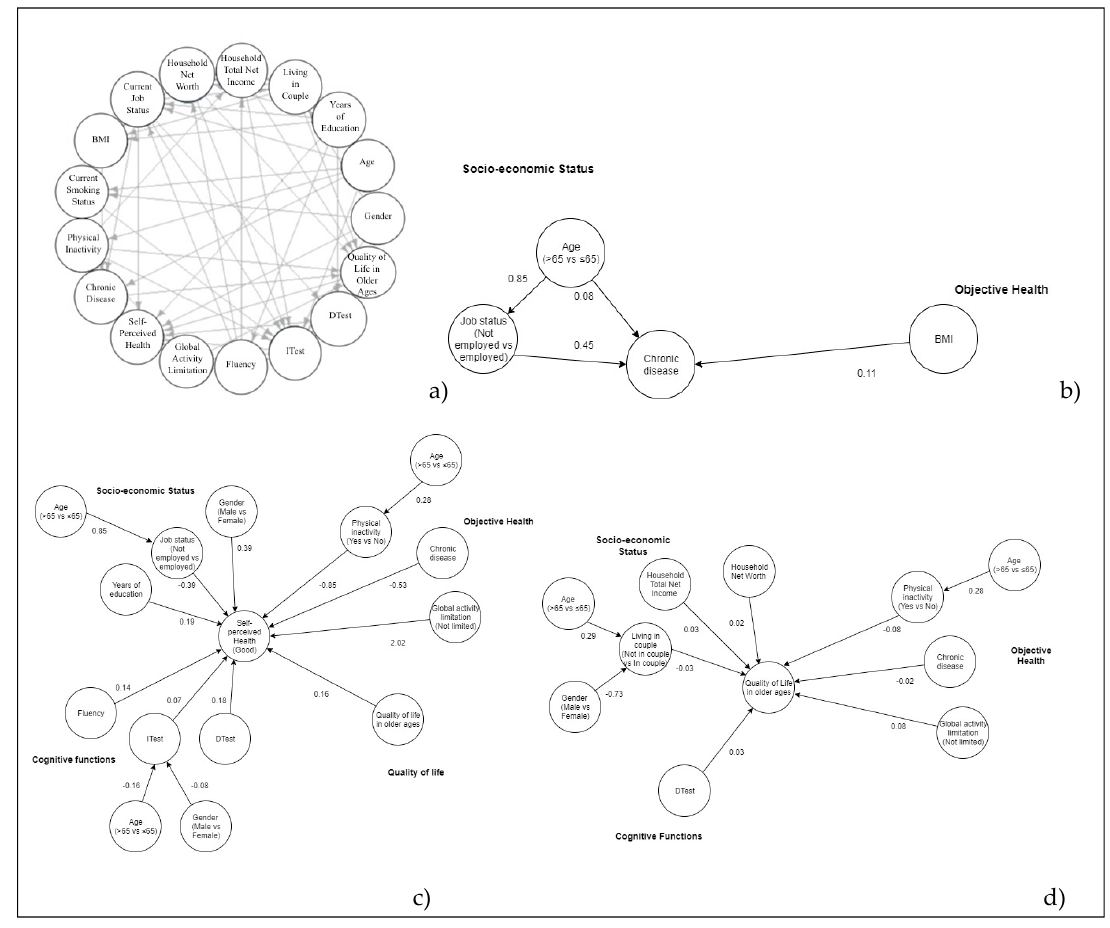
Figure 3. Additive Bayesian networks describing the interrelationship for all health indicators ( a ), chronic diseases ( b ), Self-perceived health ( c ), QoL ( d ) for Spanish elderly. Source: The Survey on Health, Aging, and Retirement in Europe, wave 6th, 2015 year. BMI = Body Mass Index, Itest = Immediate verbal recall test, Dtest = Delayed verbal recall test. Table 2. Posterior generalized linear models (GLM) estimates of direct e ff ects, with 95% credibility intervals, resulting from additive Bayesian networks (ABN) models in Italy, Spain, and Greece, 2015